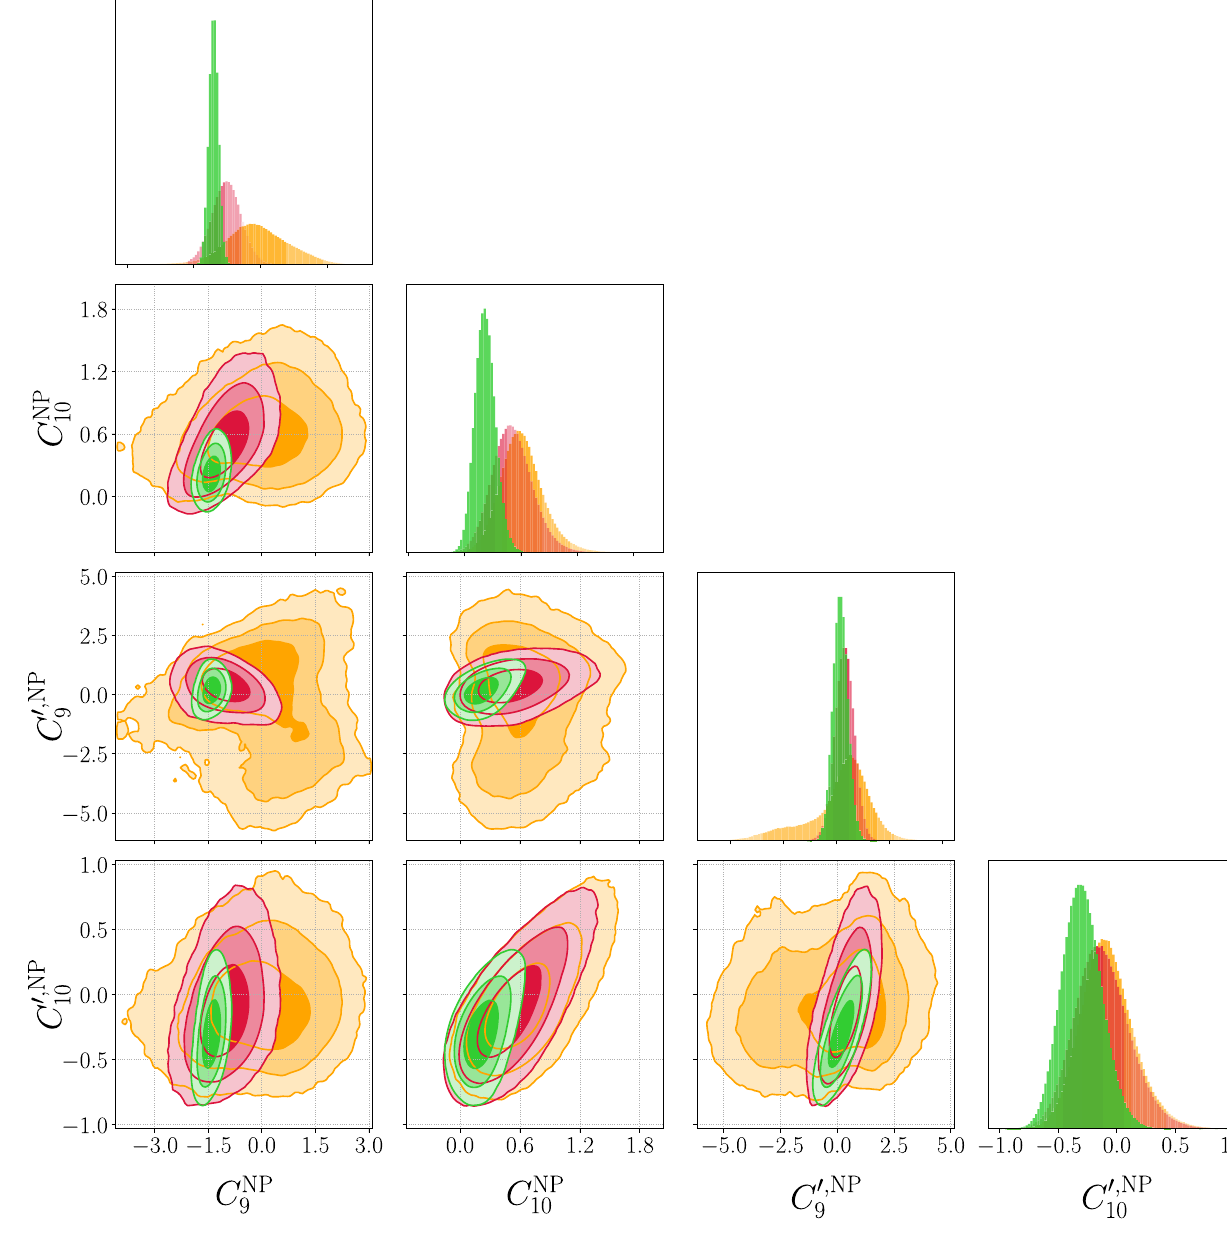
, C NP , C (cid:8) , NP and C (cid:8) , NP . Contours and colours as in Fig. 9 10 9 10